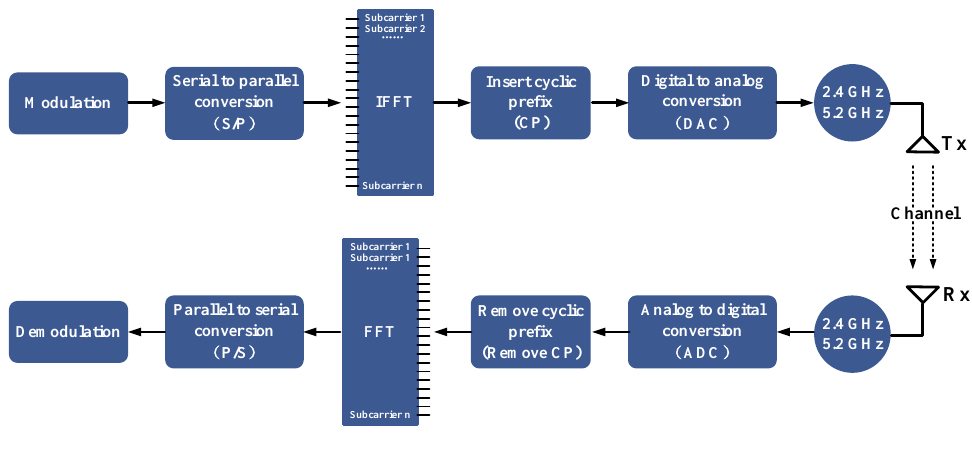
Figure 1. Principle of OFDM.